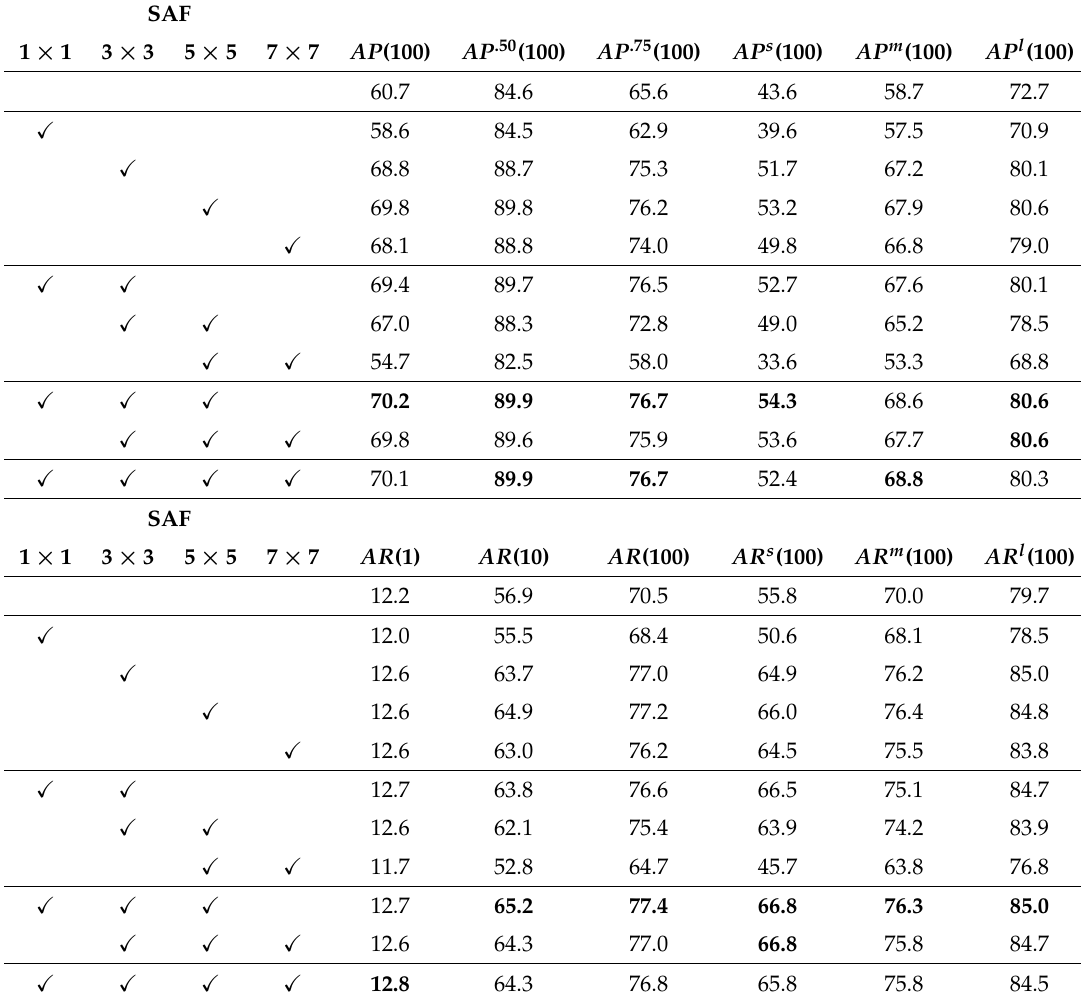
Table 4. The detection performance of average precision metrics and average recall metrics with different SAF configurations on the nuScenes validation dataset. The configuration of “1 × 1” stands for a convolution layer with kernel size 1 × 1 × 256 × 1, stride (1, 1), padding [0, 0]. As for the layers